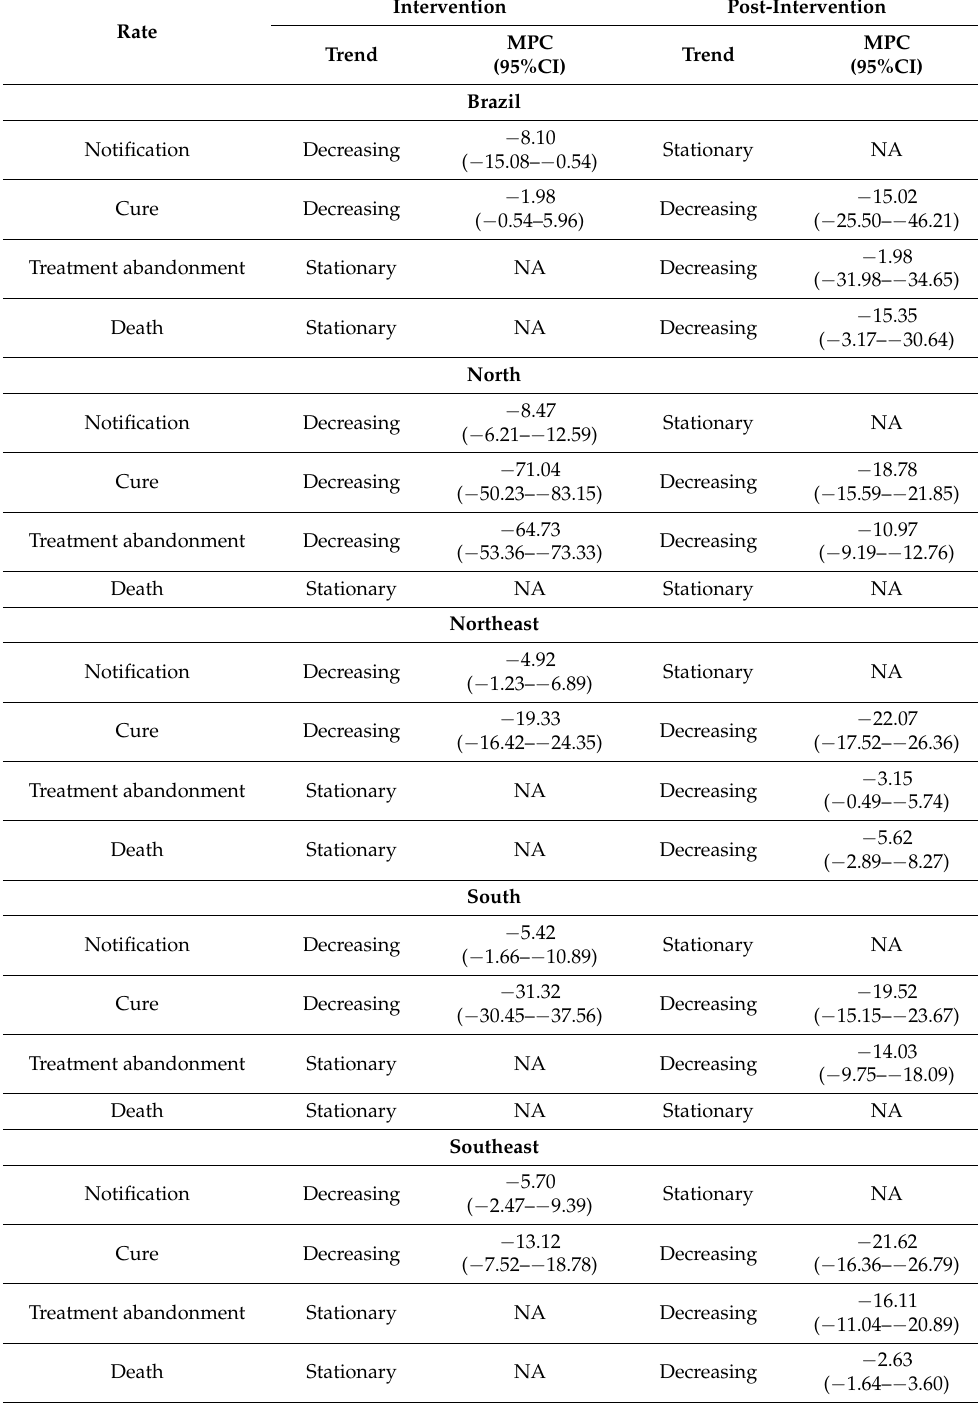
Table 2. Impact of COVID-19 on the temporal trend of tuberculosis and outcomes in Brazil and its macro-regions